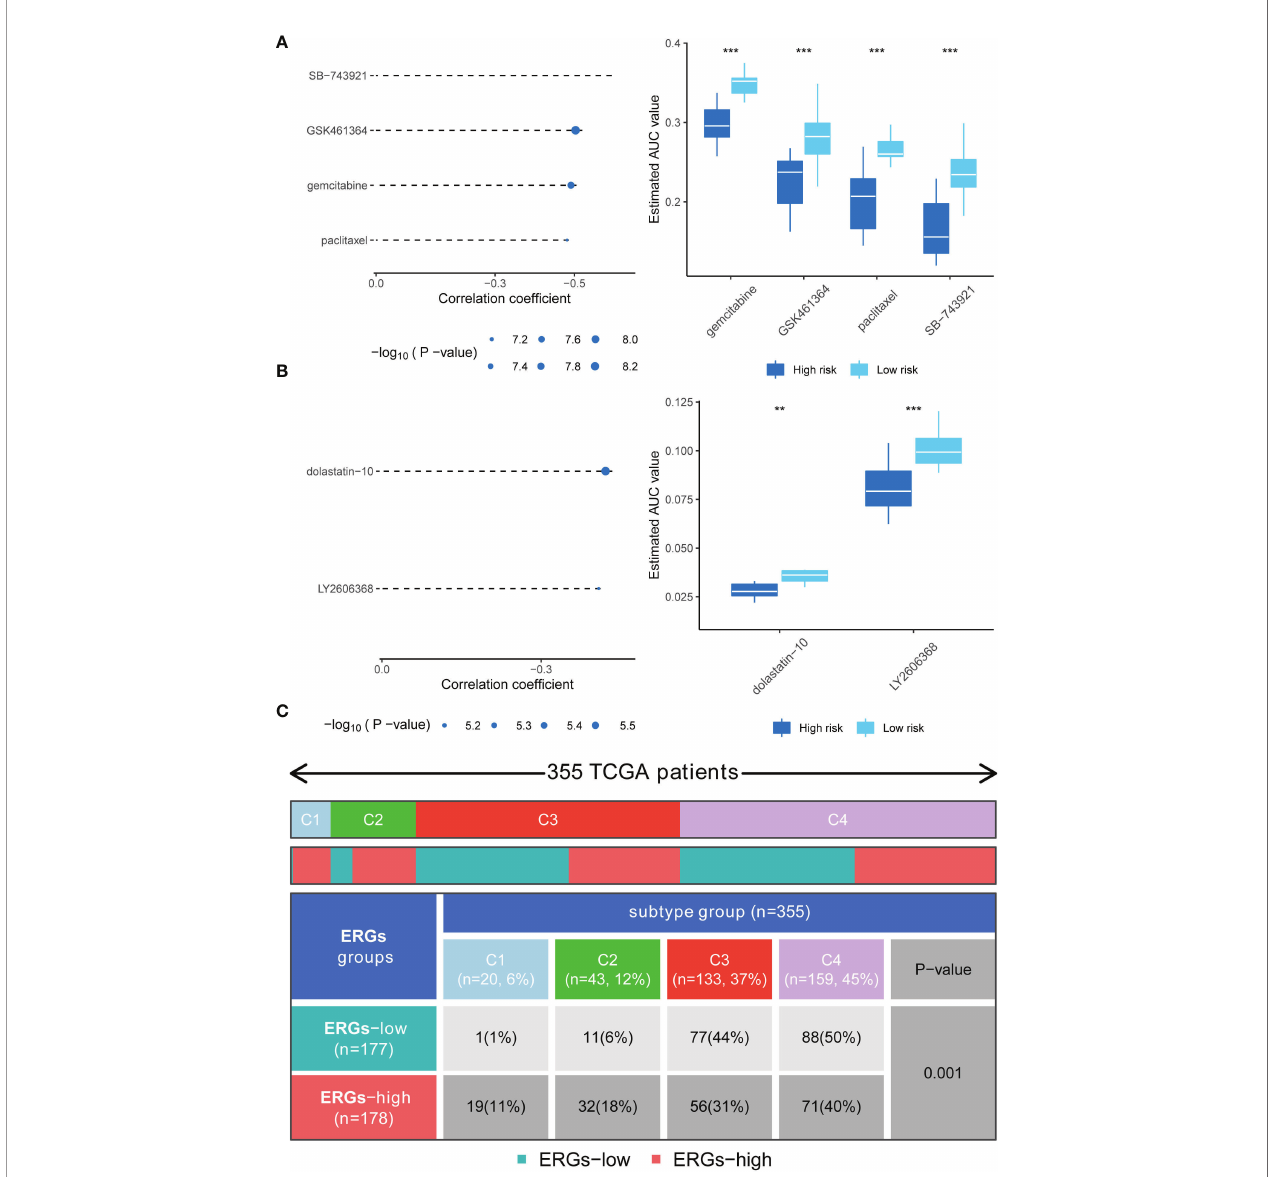
FIGURE 6 | Drug sensitivity in high-risk score patients and the immune and molecular subtypes. (A) Four CTRP-derived compounds (including SB-743921, GSK461364, gemcitabine, and paclitaxel); (B) Two PRISM-derived compounds (including dolastatin-10 and LY2606368); (C) Relationship between immune subtypes and the risk signature. ** indicate P < 0.01; *** indicate P <